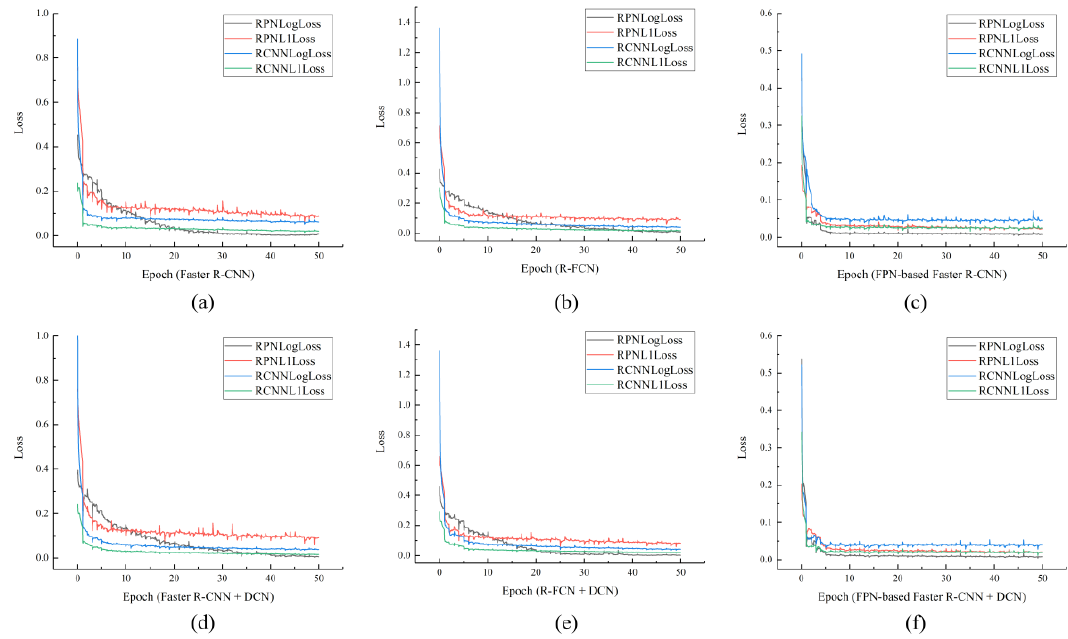
Figure 11. Training loss against epoch. Original framework without adding deformable modules: ( a – c ); framework combined with deformable modules: ( d – f ). (Note: Deformable modules conveniently represented as DCN in all figures).